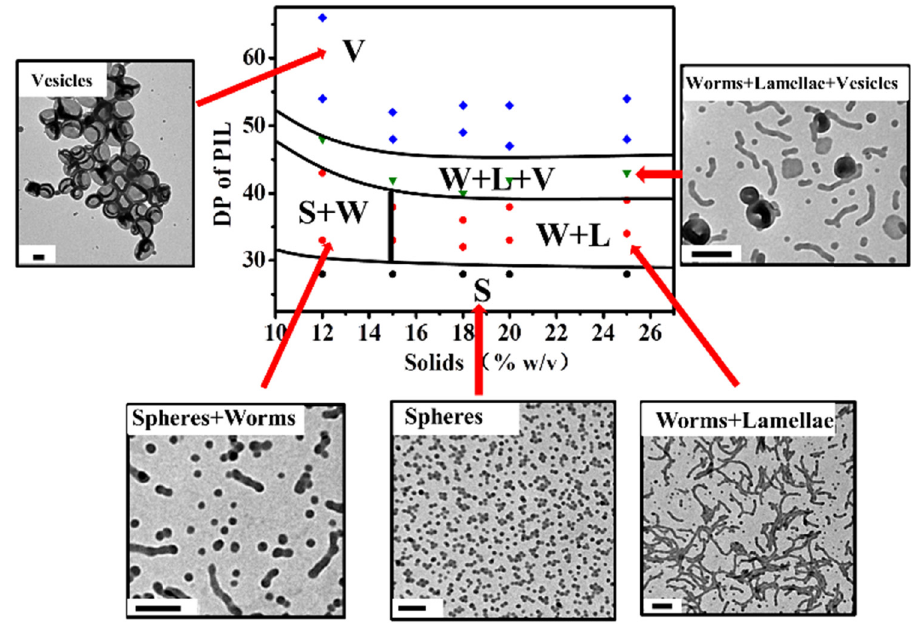
Figure 3: Morphology diagram with representative TEM micrographs for PDMA 43 - b - P ([ BVBIm ][ PF 6 ]) x nano - objects ( scale bar 200 nm ) synthesized via ethanolic RAFT dispersion polymerization at